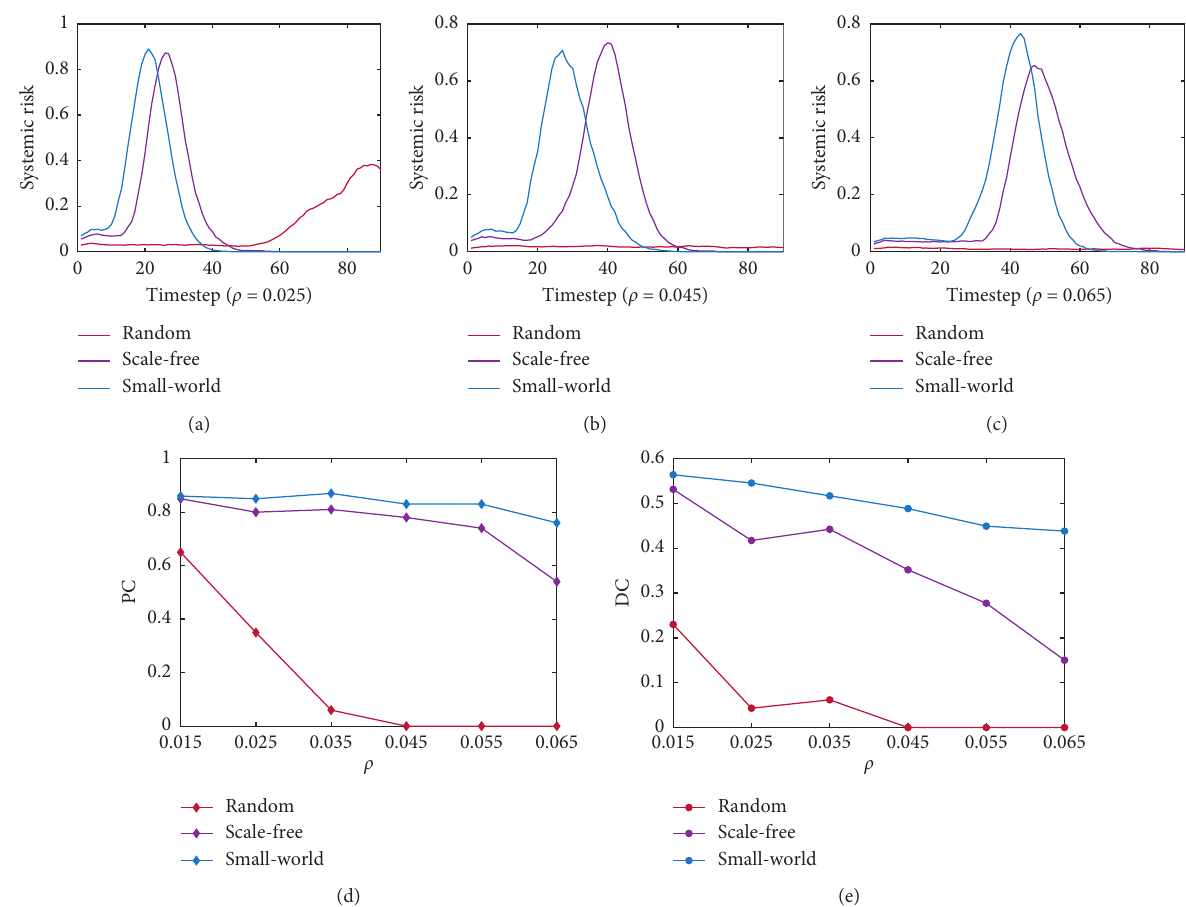
Figure 4: Evolution results of the diverse interbank networks under different